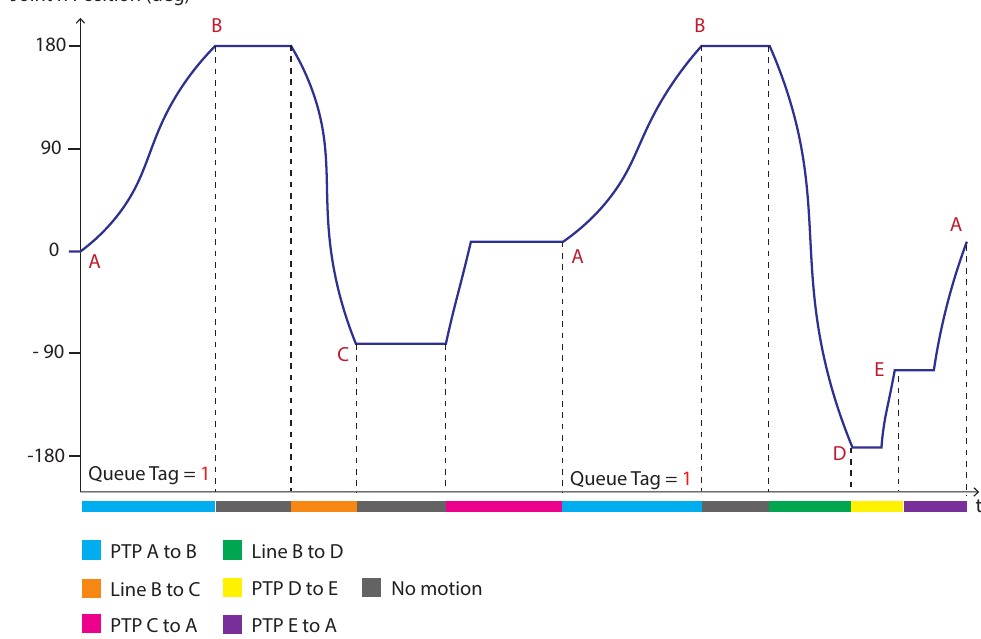
Figure 2. Example of a single joint n position acquisition during the execution of the “Test” program. The colors below the graph’s x axis represent the motion commands executed during the